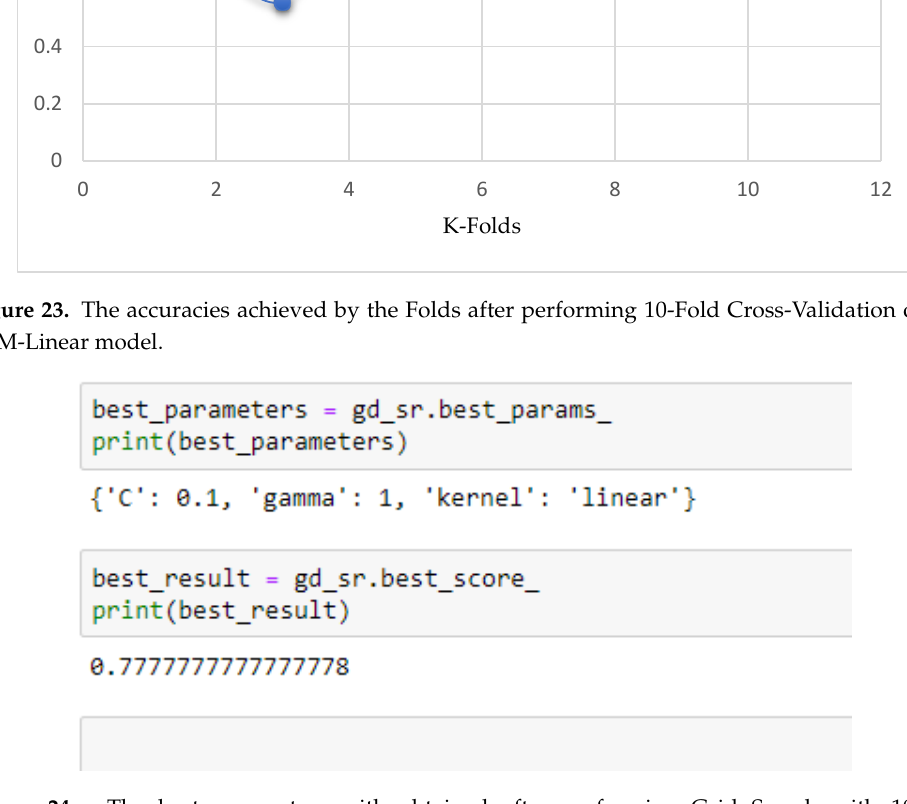
Figure 24. The best parameters with obtained after performing Grid Search with 10-Fold Cross- Validation on the SVM-Linear model.